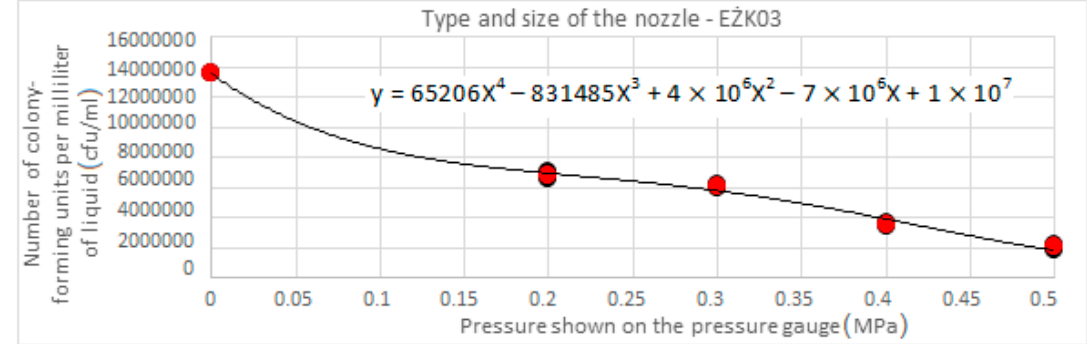
Figure 3. The influence of pressure on survival of cfu/mL of liquid for E Ż K025.